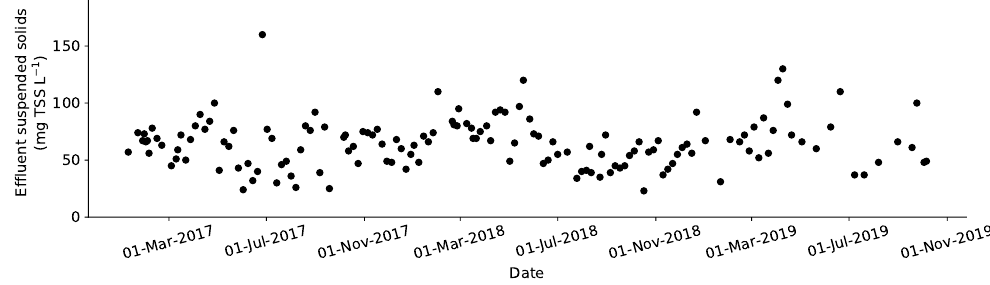
Figure 2. The effluent suspended solids (ESS) concentrations, measured at the effluent weir in the settling tanks of the high rate activated sludge (HRAS) system under study (January 2017–November